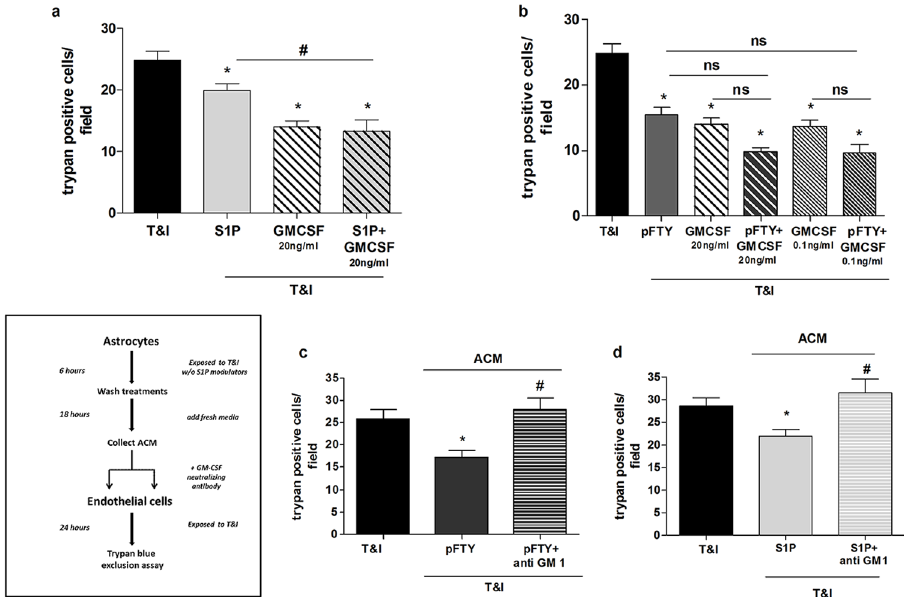
Fig 5. GM-CSF reduces hBMVEC death induced by cytokines. a . hBMVEC were exposed to T&I in the presence of GM-CSF (20 ng/ml) either alone or in combination with S1P (50 nM). The protection induced